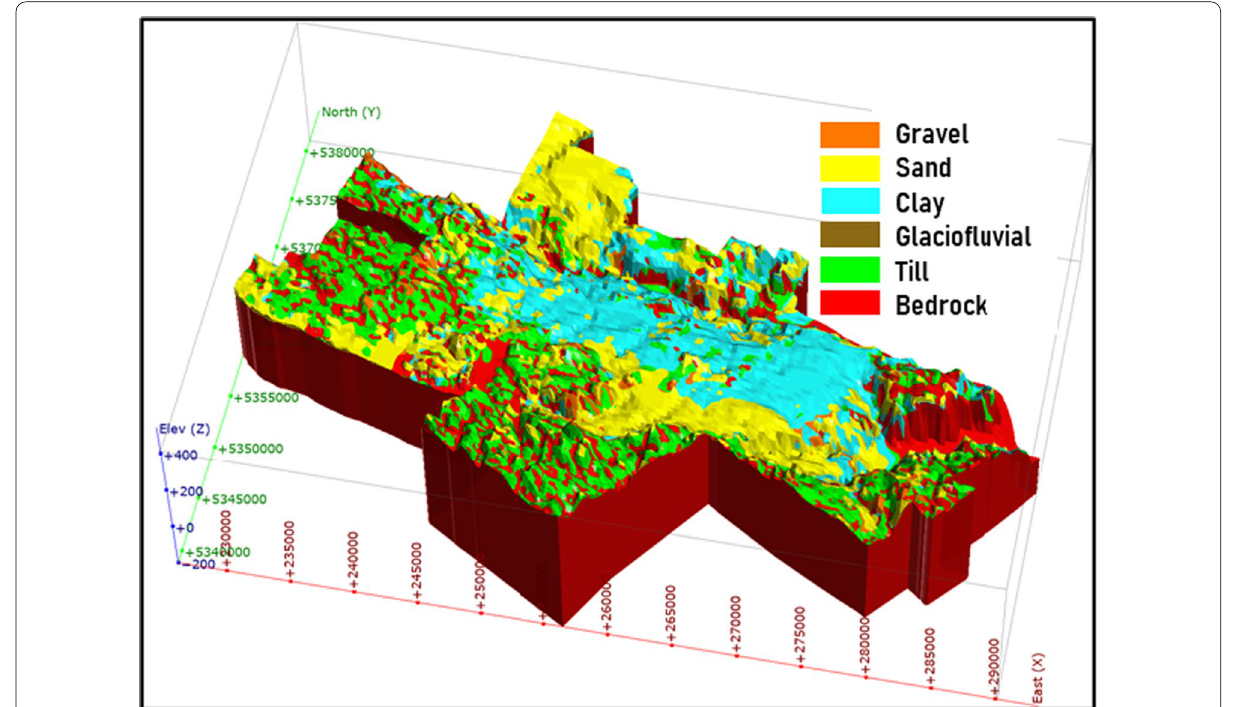
Fig. 2. 3D geological model of the study area ( modified from Foulon et al.